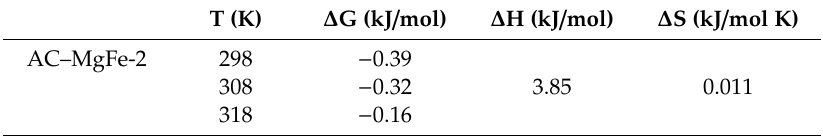
Table 5. Thermodynamic parameters of phenol adsorption onto AC–MgFe composites. T